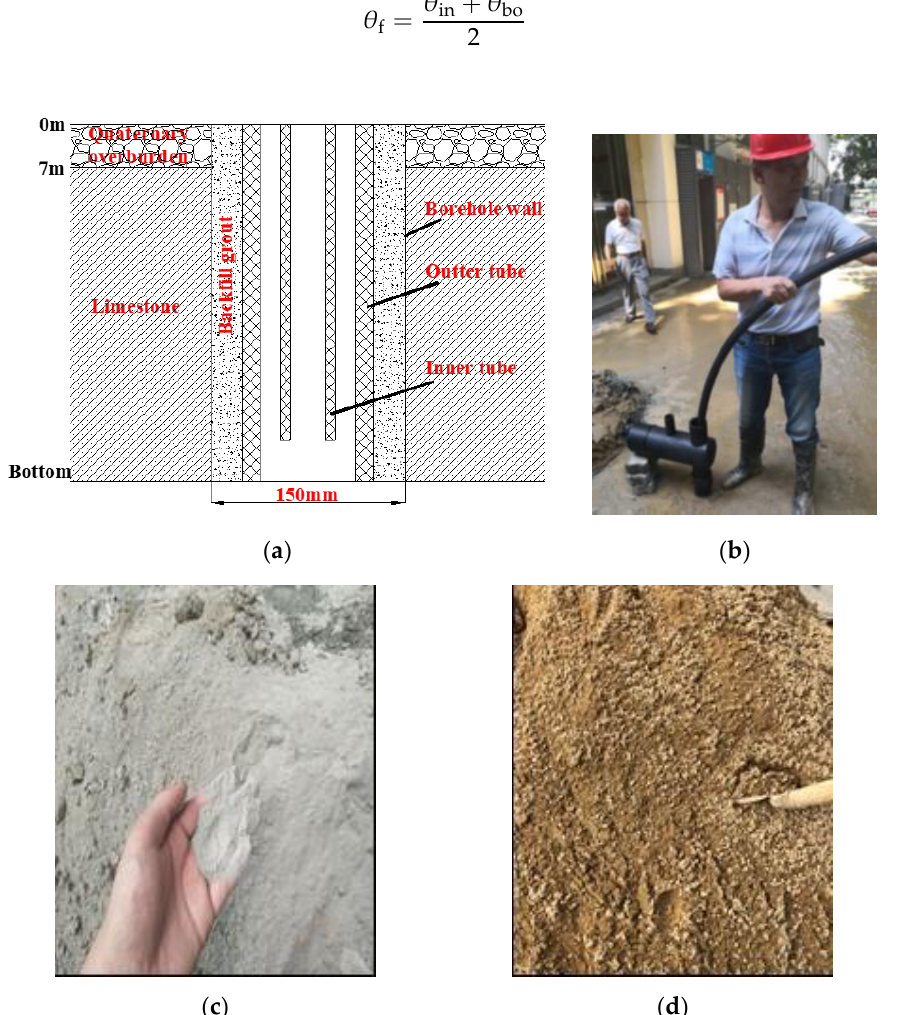
Figure 1. ( a ) Stratum profile. ( b ) CBHE installation. ( c ) Limestone powder. ( d ) Medium–coarse sand.